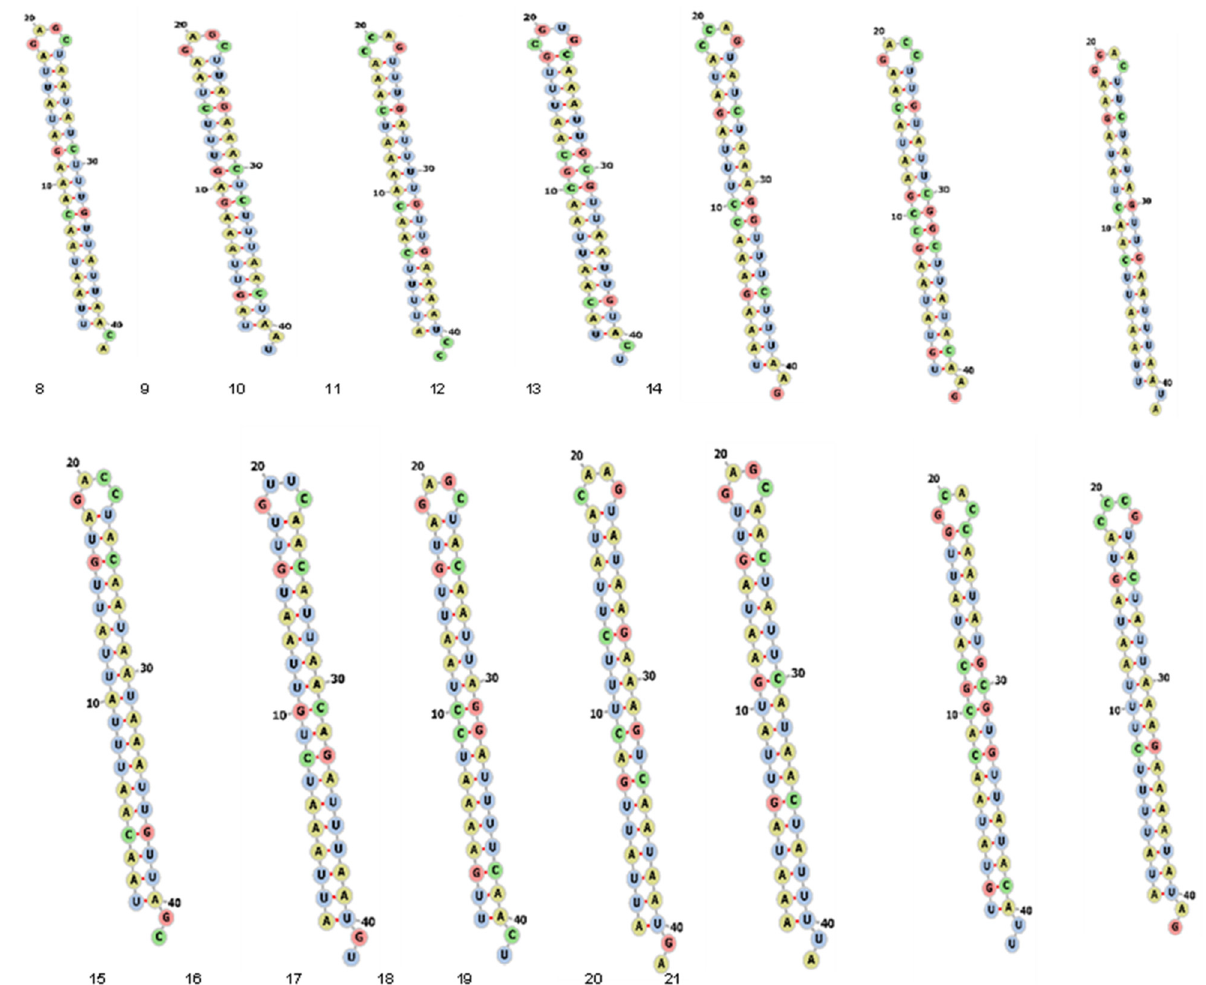
Figure 6. Predicted secondary structure of selected siRNAs from the orf1ab region.